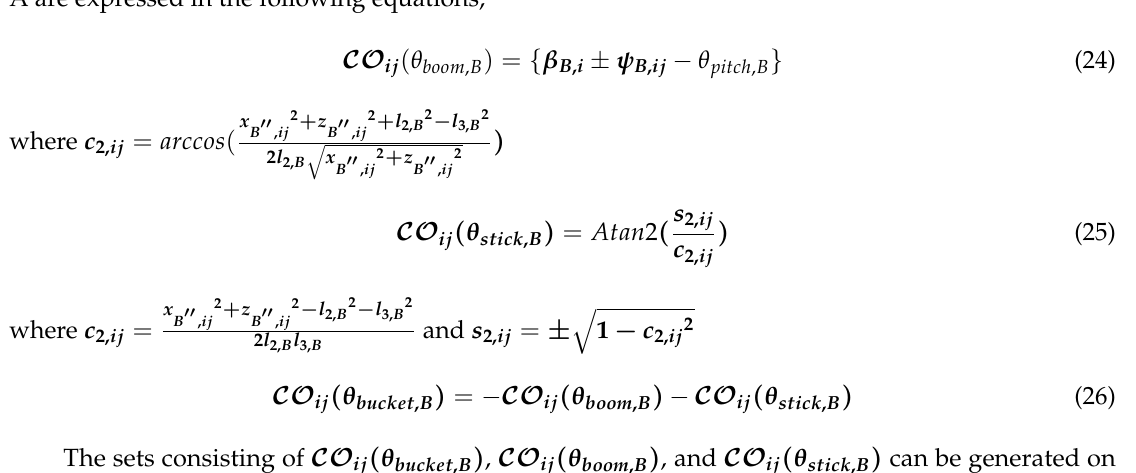
Figure 5. The parameters β , ψ , ( x specific numbers representing this posture in a collision status with Excavator